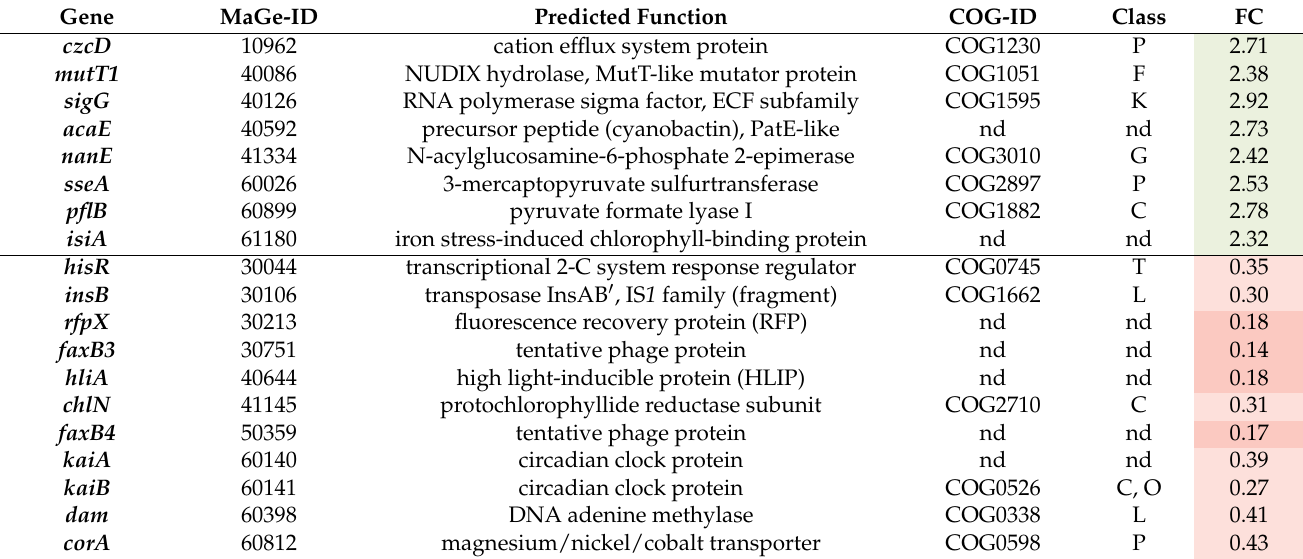
Table 3. Irradiation-induced and repressed genes of known function in P2 but not in